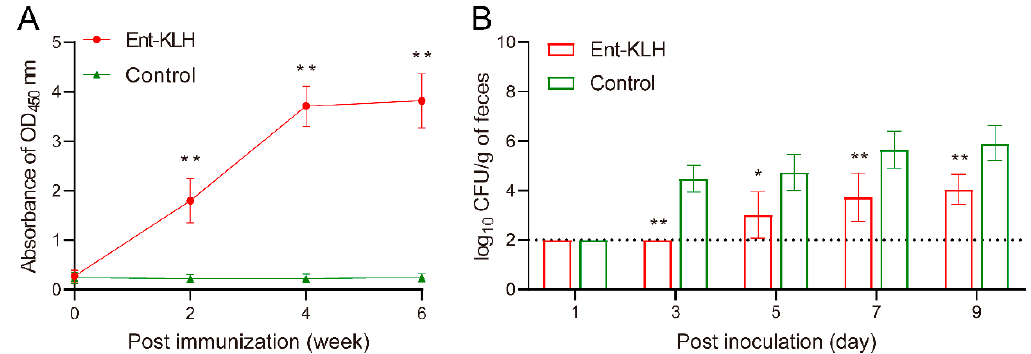
Figure 3. Enterobactin-specific immune response and protective efficacy of the Ent–KLH conjugate vaccine to mitigate C. jejuni colonization in the chicken intestine (Trial A with a total of three immunizations). ( A ) The Ent-specific IgG in the chickens immunized with Ent–KLH or PBS. Each point represents the average of OD 450 absorbance from 25 individual serum samples (200-fold dilution) with standard deviation indicated by error bar. ( B ) Comparison of colonization of C. jejuni NCTC 11168 in the chickens immunized with Ent–KLH or PBS. Each bar represents mean CFU / g feces ± the standard deviation in each group. The dotted line indicates detection limit. * p < 0.05, ** p <